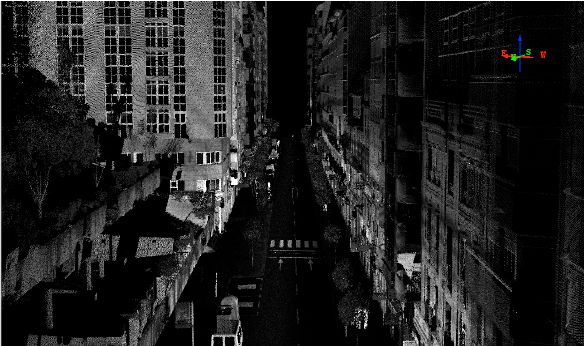
Figure 9. A 3D view of the point cloud collected in the Progreso Street (Ourense, Spain).